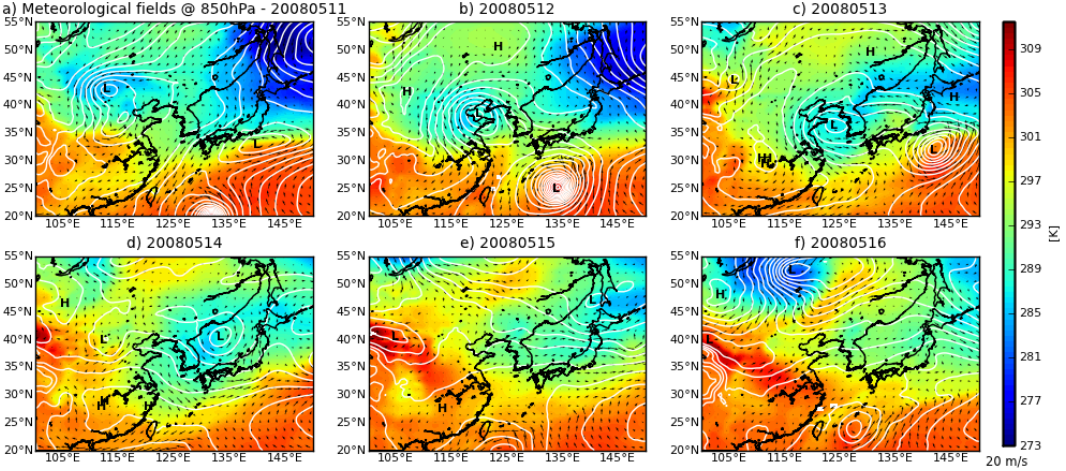
Figure 4. Meteorological situation given at 850hPa from 11 to 16 May 2008. The coloured areas represent the equivalent potential tempera- ture and the white contours the geopotential height. The “L” and “H” symbols represent the centre of lows and highs respectively. Horizontal winds are also plotted.